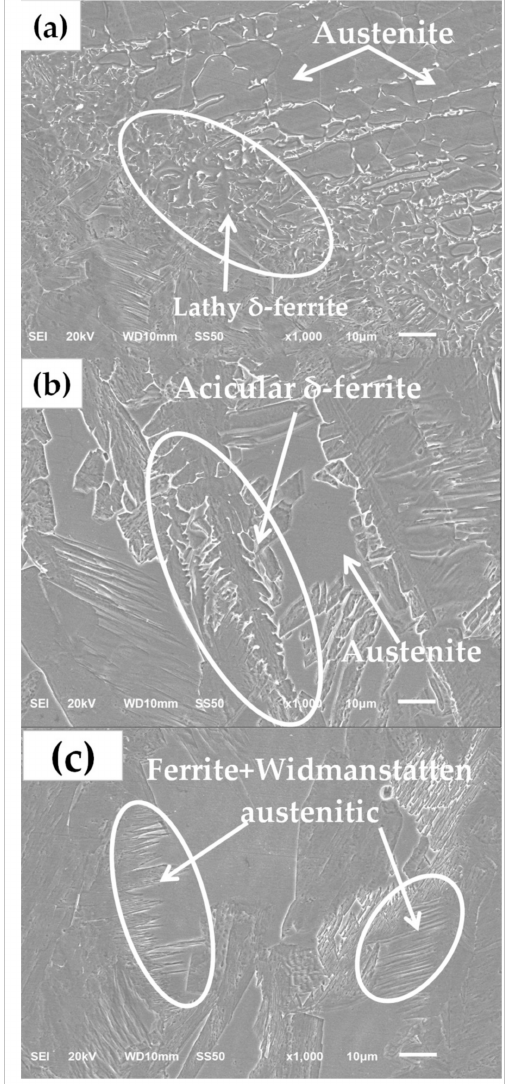
Figure 19. SEM images of the solidification mode of SUS316L / SUS425 RSW, given 25-cycle welding time, under ( a ) 7.0 kA; ( b ) 8.5 kA; ( c ) 10.0 kA weld